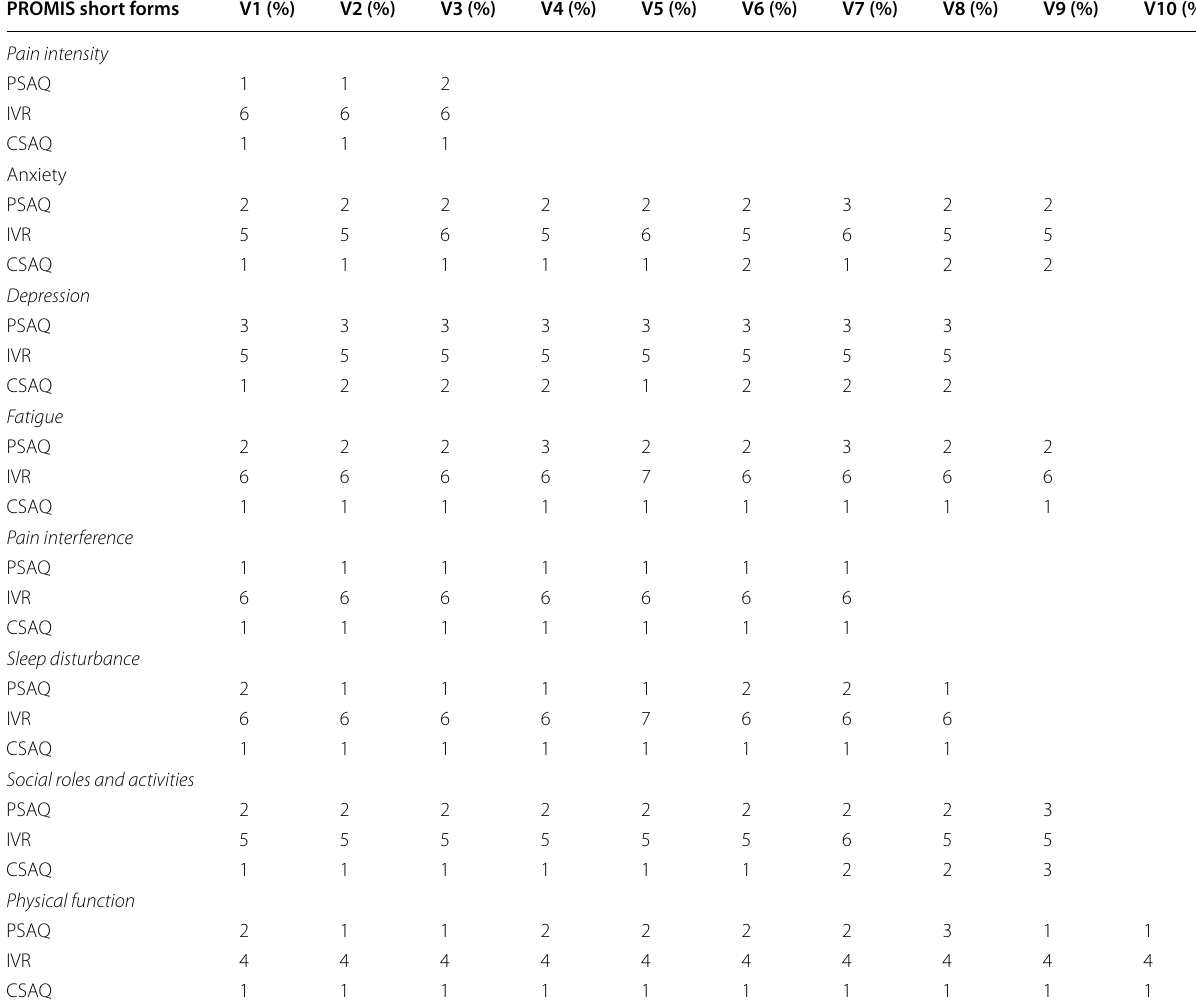
Table 8 Missing data percentage by items and modes in PROMIS